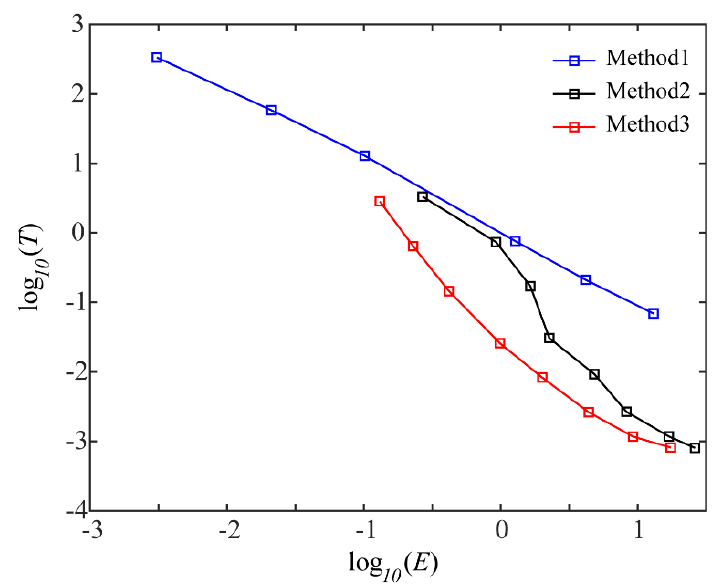
Figure 8. The average computation time ( T ) vs. the average percent error ( E ) in the common logarithm scale. The method 1 is the calculation based on triangulation. The method 2 is the Monte Carlo method using sample points from a uniform distribution on a sphere. The method 3 is the Monte Carlo method using the icosahedron-based vertices. The data points are from Figure 7.